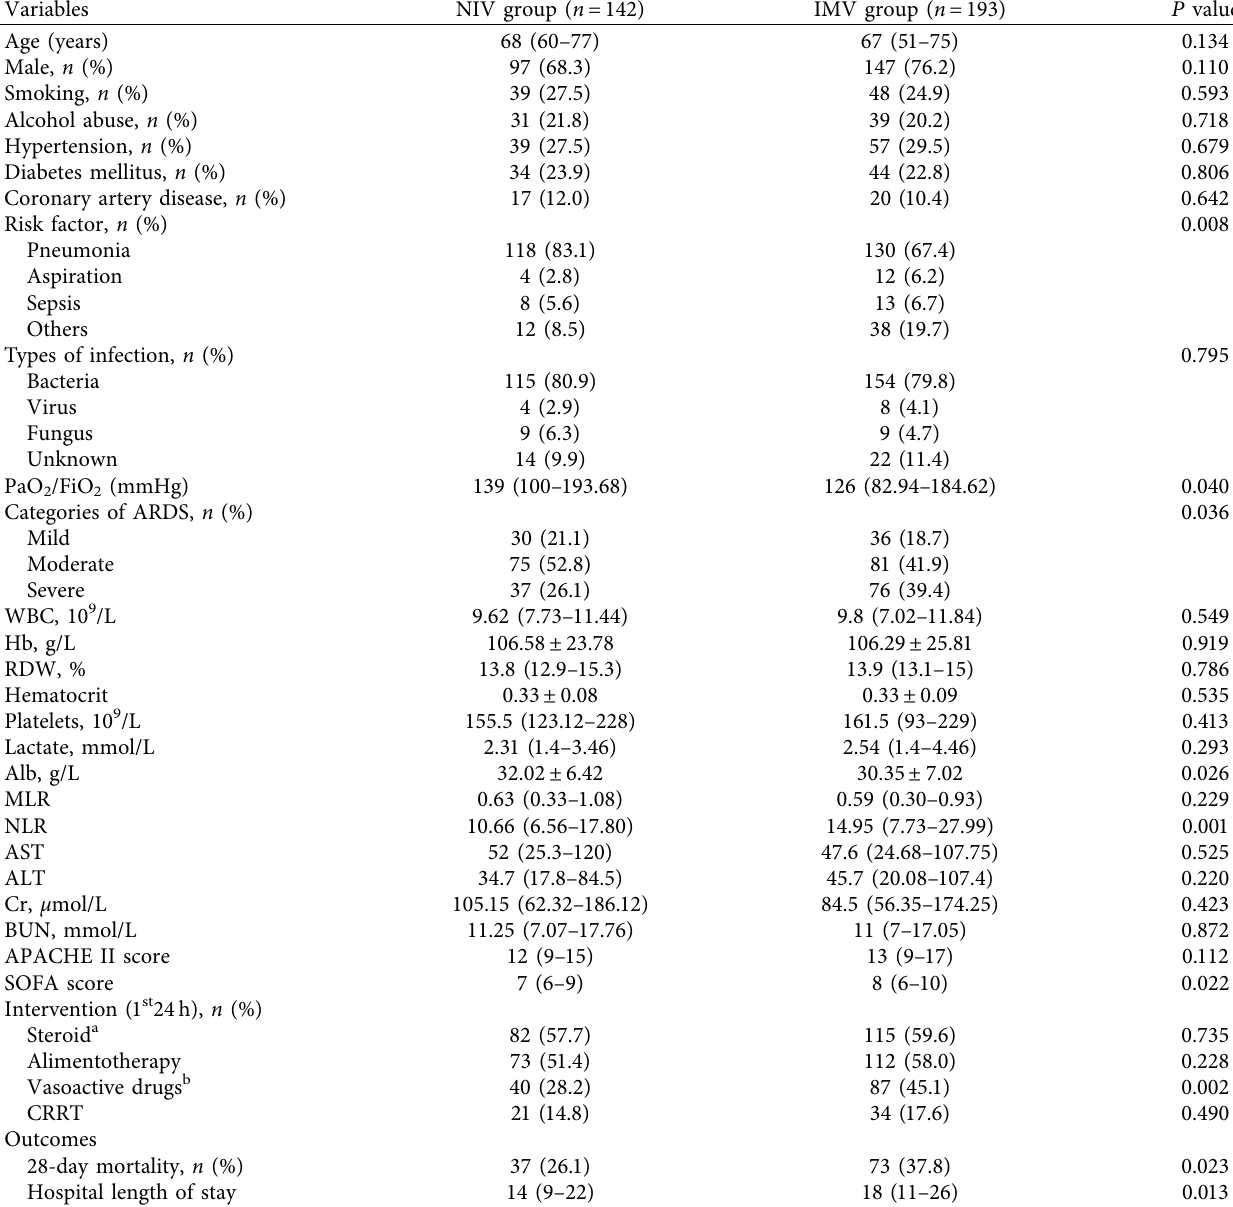
Table 2: Comparisons of baseline characteristics between the noninvasive ventilation group and the invasive mechanical ventilation group.